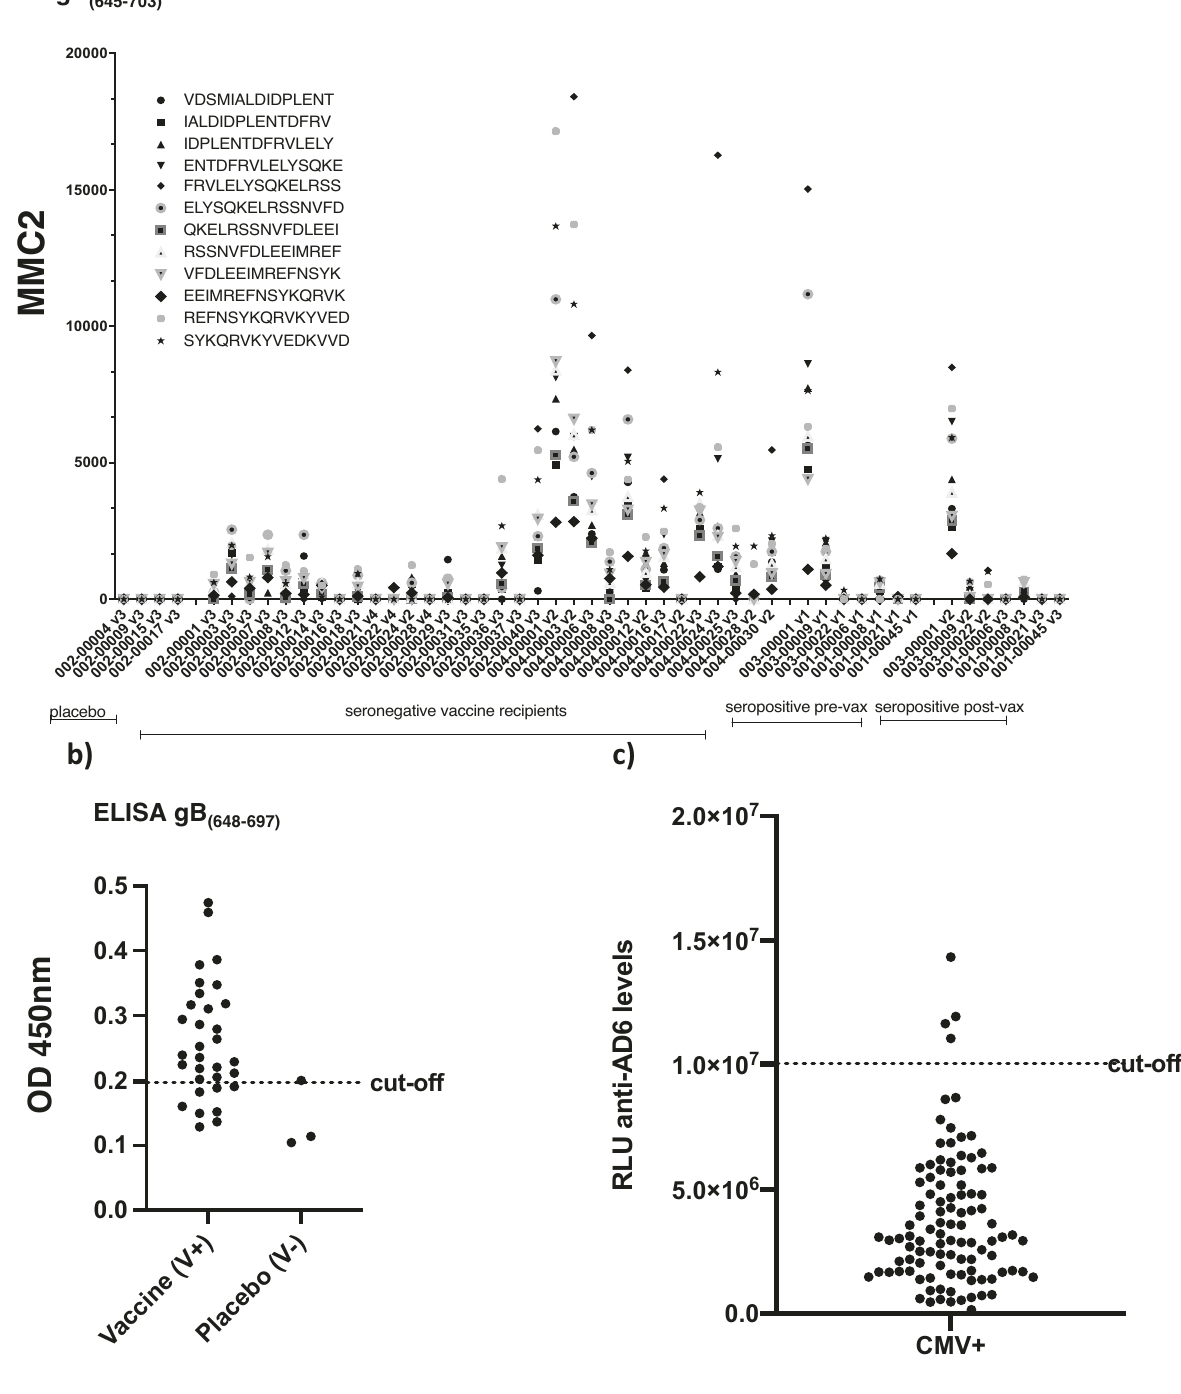
Fig. 1 | Seronegative gB/MF59 recipients develop humoral responses against novel epitopes in gB. a IgG levels against 15-mer peptides spanning gB (645 – 703) (Towne) in seronegative vaccine recipients after the second dose of the vaccine. Microarrays were scanned using a high-resolution fl uorescence scanner. For each spot, mean signal intensity was extracted (between 0 and 65535 arbitrary units). The MMC2 equals the mean value of all three instances on the microarray. Each peptide is represented by the symbol in the key ( b ) Anti-AD-6 levels (gB (648 – 697)